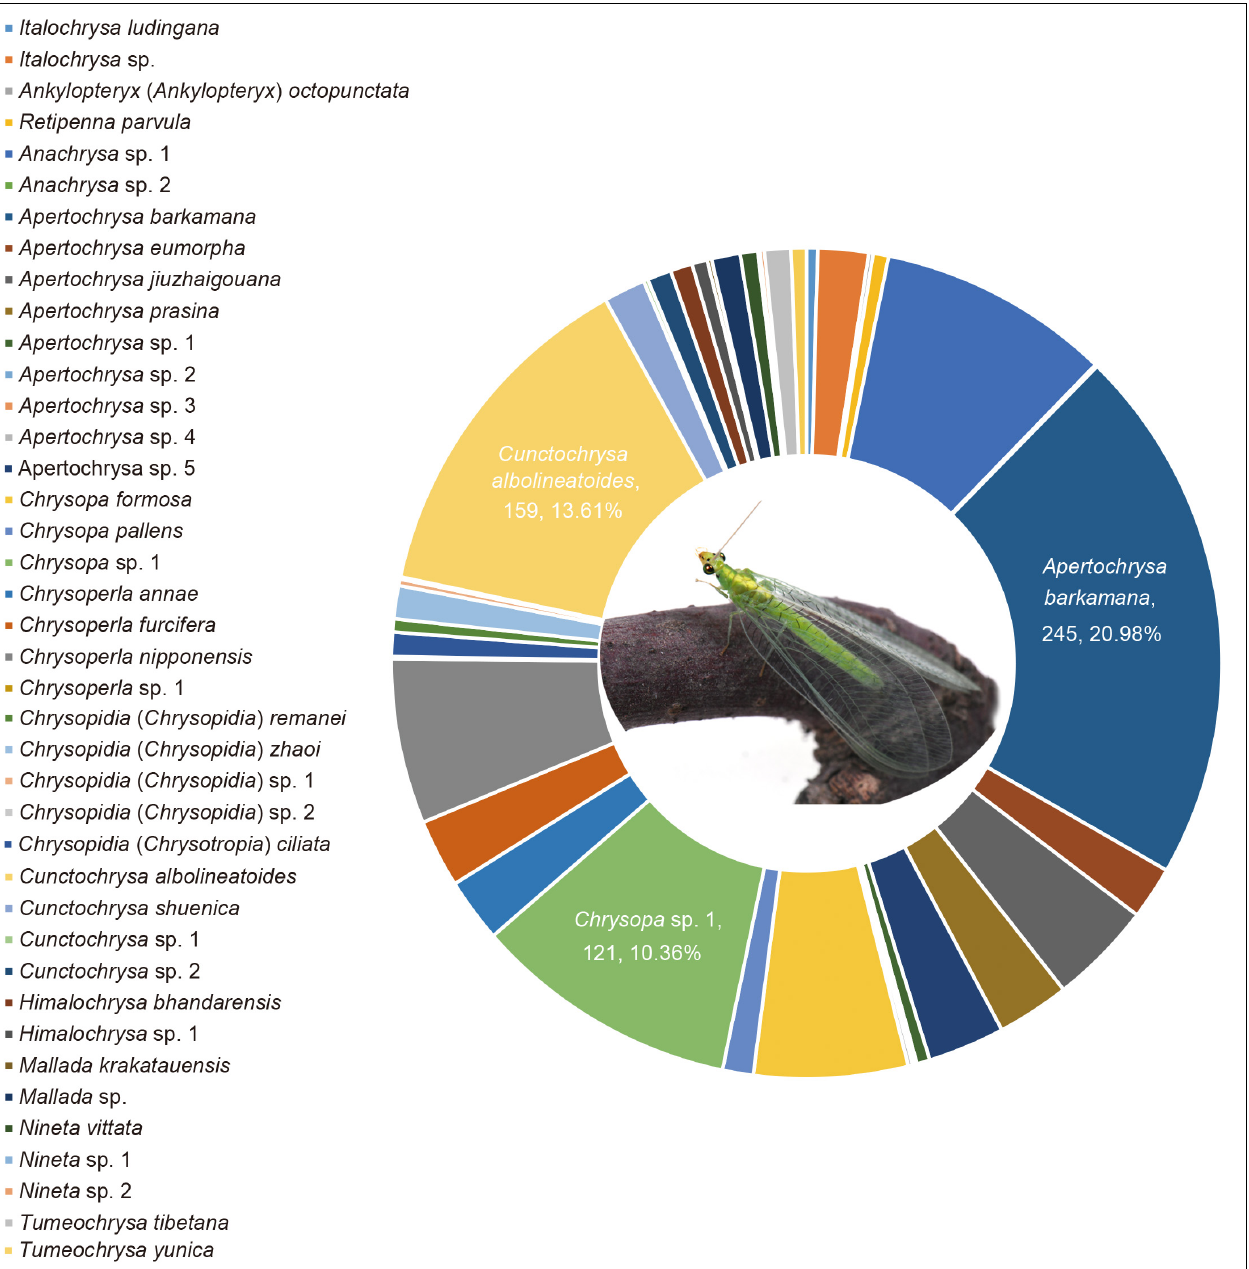
FIGURE 4 | Percentage abundance of total specimens of the green lacewings from the Shaluli